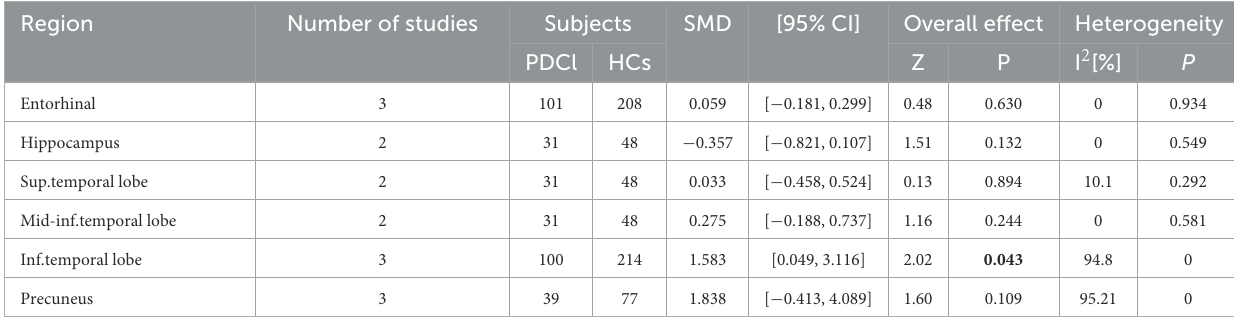
TABLE 4 Random effects meta-analyses results between PDCI and HCs